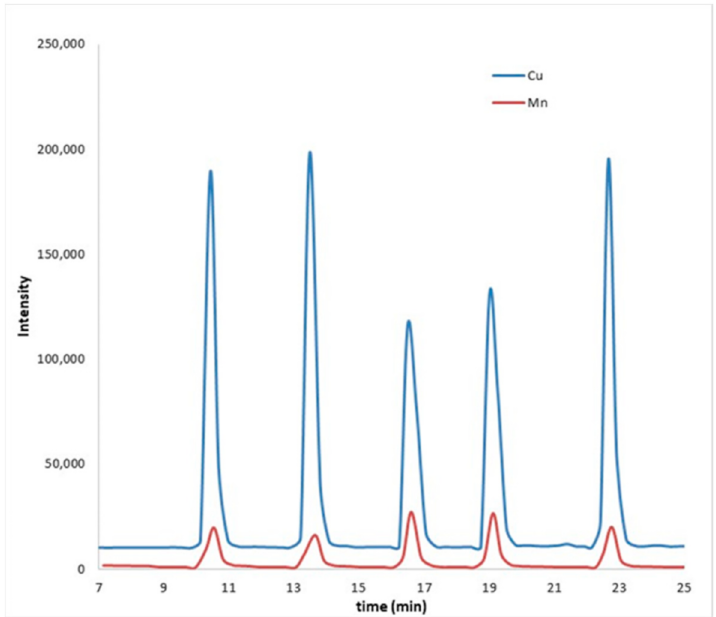
Figure 1. Recording of the signal corresponding to a standard solution (2 mg L − 1 ) of Cu (blue) and Mn